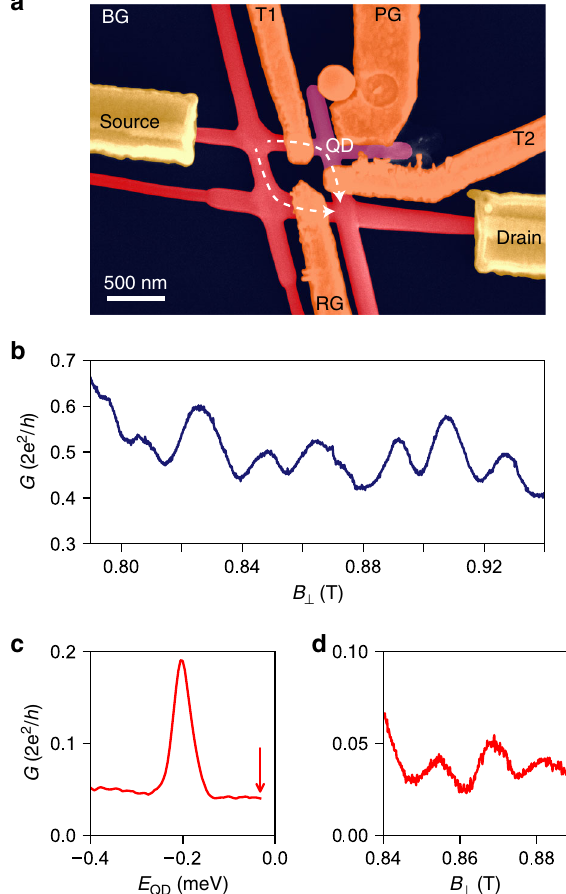
Fig. 2 Aharonov – Bohm oscillations in an InSb nanowire network. a False- colour scanning electron micrograph of the device: in red the nanowire network, in gold the leads, in orange the gates and in pink the quantum dot region. An additional illustration and a schematic of the device are shown in “ Methods ” . b Conductance at zero bias voltage G ( V = 0) as a function of SD the perpendicular fi eld B ⊥ in the open regime (i.e., with no QD de fi ned) manifesting AB oscillations. c G ( V SD = 0) vs. E QD (the dot electrochemical potential) when the quantum dot is de fi ned. d G ( V SD = 0) vs. B ⊥ when the dot is in the cotunnelling regime (cf. Coulomb valley indicated by the red arrow in ( c